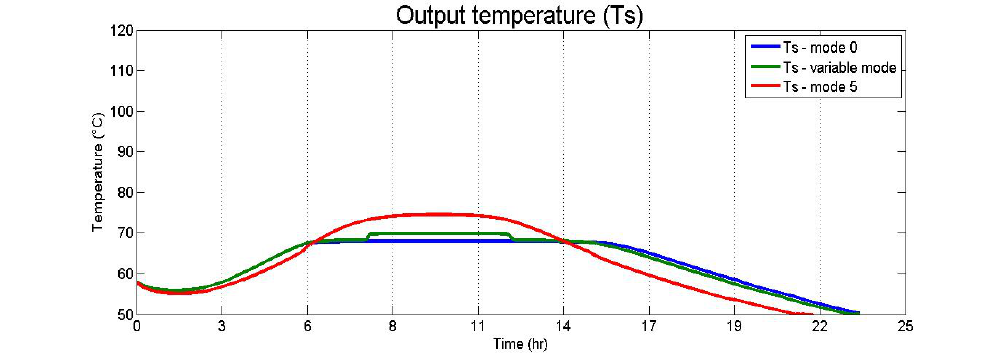
Figure 23. Comparison of the generator temperature of the three modes of operation with a solar radiation of 500 kW/m 2